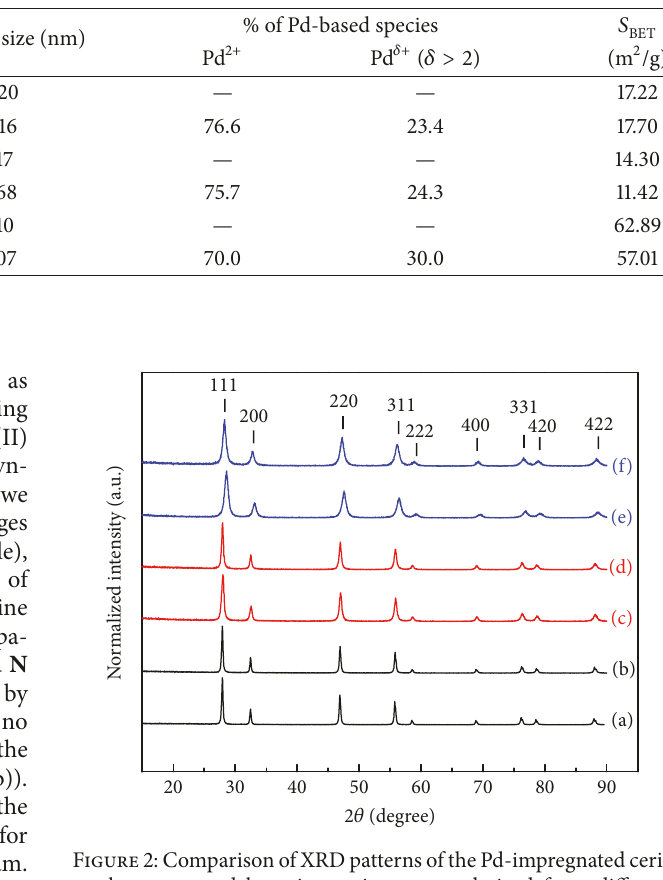
Table 1: Crystallite size calculated by Scherrer equation according to the XRD patterns, percentage of different chemical states of the Pd-based species according to the Pd 3d XPS spectra, and specific surface area derived from BET calculation of N 2 adsorption isotherm at 77 K ( 𝑆 BET ) of the obtained Pd-impregnated ceria catalysts.